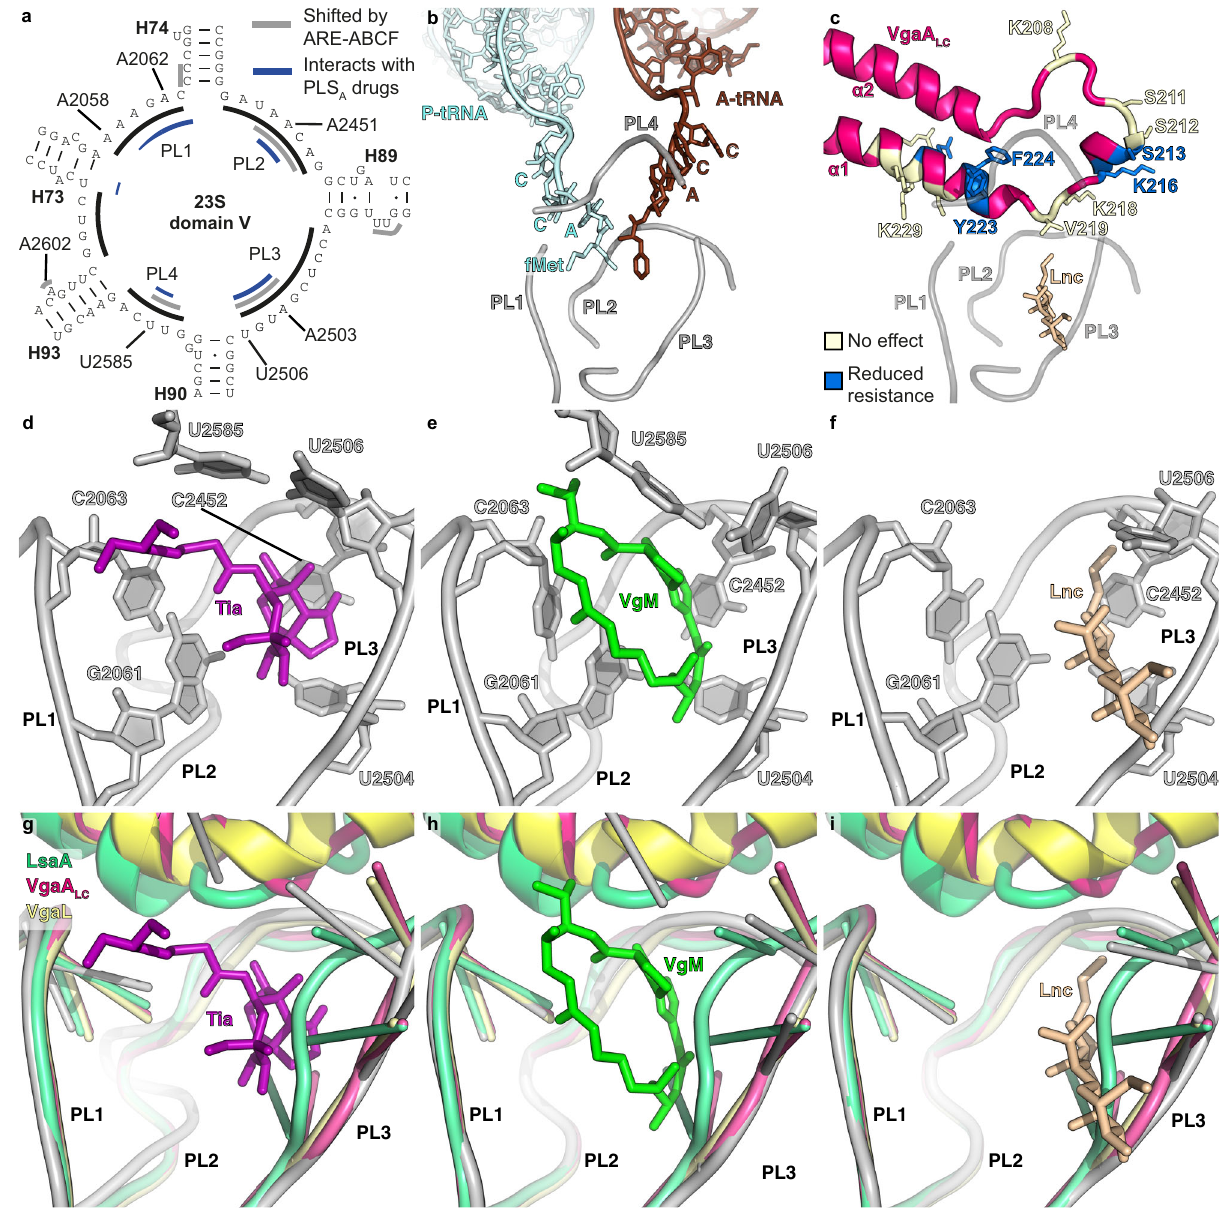
Fig. 5 ARE-ABCF binding induces conformational changes at the PTC. a Secondary structure of peptidyl transferase ring within domain V of the 23S rRNA, highlighting residues within PTC loops 1 – 4 (PL1 – 4) that comprise the binding site of PLS A antibiotics (blue) and/or undergo conformational changes upon ARE-ABCF binding (grey). b View of the PTC in the pre-peptidyl transfer state (PDB 1VY4) 103 with tRNAs and PLs 1 – 4 from a labelled. c Same view as b , except with the VgaA LC structure shown. For reference, lincomycin is also included (PDB 5HKV) 6 . Residues coloured yellow had no effect on resistance when mutated to alanine. For residues coloured blue, antibiotic resistance was signi fi cantly affected when mutated to alanine. d – f Binding site of d tiamulin (Tia, magenta, PDB 1XBP, 3.5 Å) 2 , e virginiamycin M (VgM, green, PDB 4U25, 2.9 Å) 61 and f lincomycin (Lnc, tan, PDB 5HKV, 3.7 Å) 6 on the ribosome. g – i Comparison of conformations of rRNA nucleotides comprising the g Tia, h VgM and i Lnc binding site (shown as grey cartoon ladder representation), with rRNA conformations when LsaA (green), VgaA LC (magenta) or VgaL (yellow) are